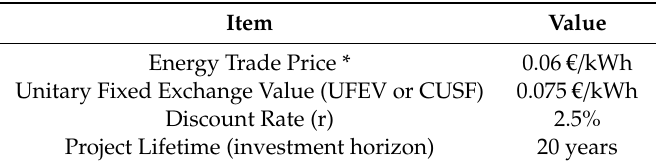
Table 10. Further economic